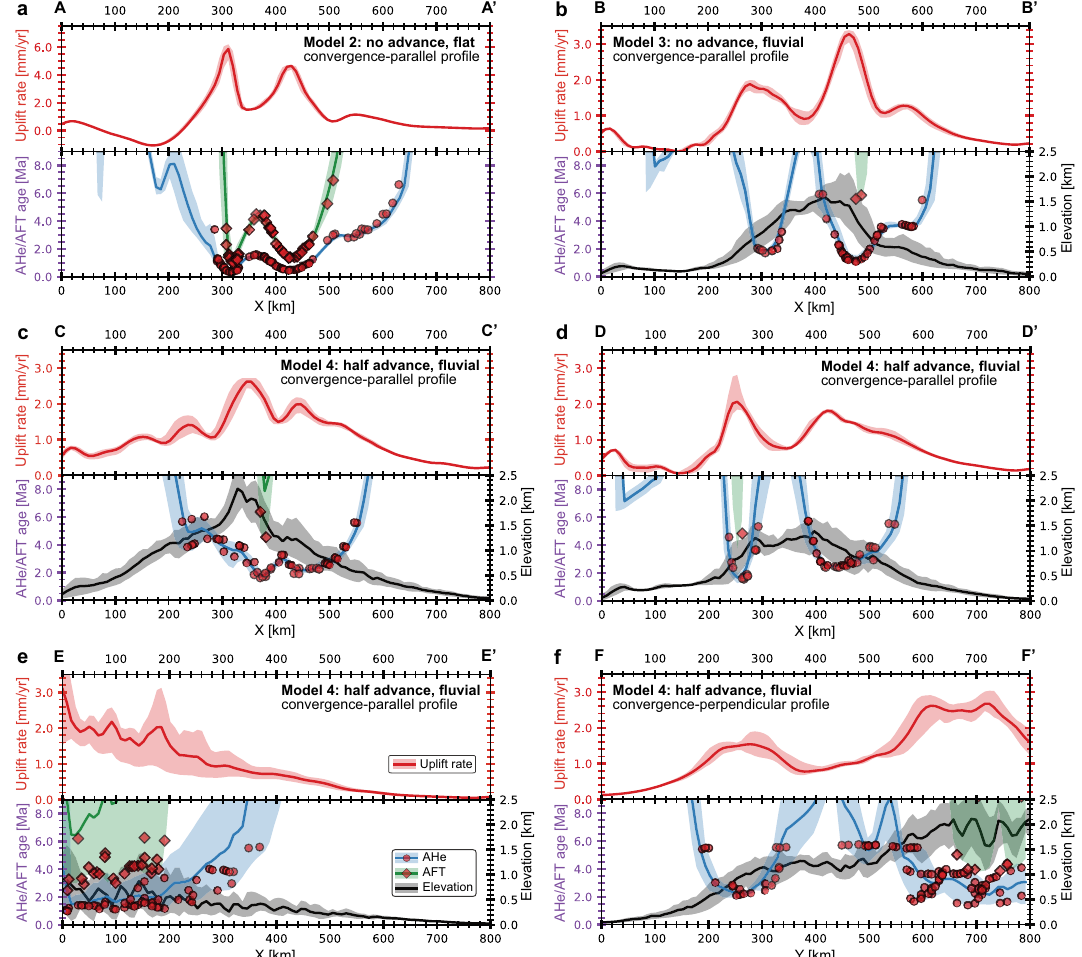
Figure 6. Swath profiles of rock uplift rates (red lines; upper panels), topography, and predicted AHe and AFT ages (black, blue, and green lines; lower panels) for the following experiments after 6 Myr modelling time: ( a ) model 2 (total erosion; no upper plate advance); ( b ) model 3 (fluvial erosion; no upper plate advance); ( c – f ) model 4 (fluvial erosion; half upper plate advance). Zones with light colors indicate the variation of the corresponding parameters at 40 km intervals in the profile-perpendicular direction. The red circles (AHe) and diamonds (AFT) indicate the cooling ages extracted from the tracking particles, while the continuous blue (AHe) and green (AFT) lines denote their interpolation (which is also shown in the corresponding map views in Fig. 5). Profiles A-A’, B-B’, C-C’, D-D’, and E-E’ (panels “a” to “e”) are oriented parallel to the convergence, while profile F-F’ (panel “f”) has a subduction-perpendicular orientation. The locations of the profiles are shown by the dashed lines in Fig. 5. Note that the youngest cooling ages do not coincide with the highest topography, but are offset on the slopes of the orogen (panels “b” to “d”). The direct linear relationships between age and altitude are thus applicable only to limited areas, and even an inverse dependence may be reasonable. Model 3 (fluvial erosion; no upper plate advance; panel “b”) is characterized by a skewed topography in which the slope on the retro-side (right) is much steeper than on the pro-side (left), while the corresponding topographic profile is much more symmetrical when boundary velocities are evenly distributed between subducting and overriding plates (model 4; panel slopes, preferably in steep valleys with sufficient upstream drainage area, and therefore do not coincide with the highest topography (Fig. 6). Figure 7 illustrates a comparison of predicted AHe ages for model 4 (fluvial erosion; half upper plate advance) with a compilation of observed ages in southern Alaska. The youngest AHe ages (< 1 Ma; refs. 55,56 ) are reported along the Fairweather transform fault including the area of its transition to convergence within the St. Elias syntaxis and connection to the Denali fault to the north. Another observed site of relatively young cooling ages (< 5 Ma; ref. 33 ) is located above the subducted part of the Yakutat microplate within the Chugach Core (Fig. 7a). Both zones are reproduced in model 4, which shows younger thermochronological ages focused above the lateral boundary of the subducting slab and the indenter apex (Fig. 7c). Although the tectonic structures associated with these two regions of localized exhumation—dextral strike-slip/transpressional fault and indenter-centered thrust-sense decollement (Fig. 3b)—are expressed to varying degrees in all the experiments presented (Figs. 3–4),